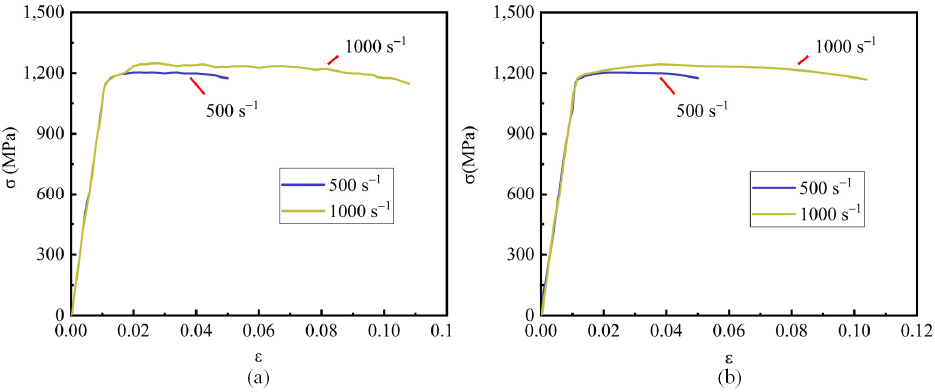
Figure 5. Dynamic tensile stress–strain curve of the smooth specimen: ( a ) experimental data; ( b ) smoothed experimental data.